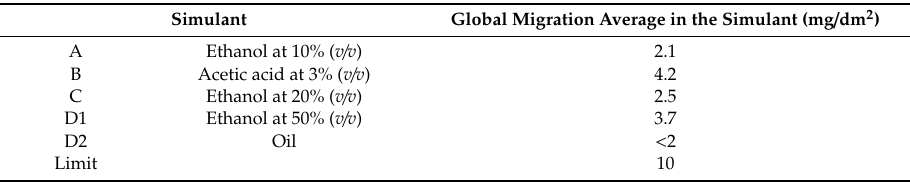
Figure 2. Release of salicylate bonded to Layered Double Hydroxides nanofiller from active film and simply blended into PE Table 1. Global migration into aqueous food simulant by filling a container UNI EN 1186-1: 2003 + UNI EN 1186-9: 2003 for the film based on the active PE filled with Layered Double Hydroxides and salicylate (contact time 10 day, temperature test 40 ◦